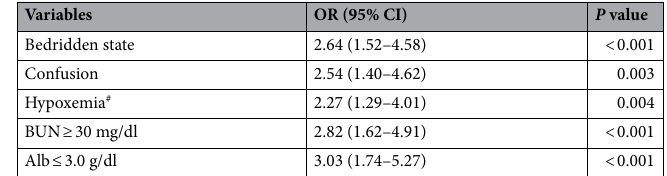
Table 3. Multivariate logistic regression analysis of prognostic factors associated with 30-day mortality. Data are presented as n (%). # Hypoxemia: SpO 2 ≤ 90% or PaO 2 ≤ 60 mmHg. OR, odds ratio; CI, confidence interval; Alb, albumin; BUN, blood urea